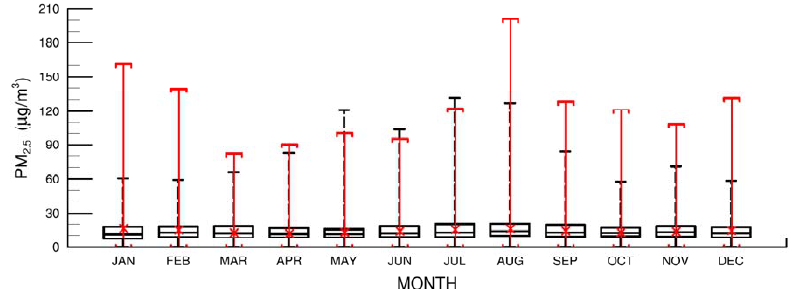
Fig. 5. Monthly statistical distributions of PM 2.5 concentrations for year 1999-2001. The black color corresponds to the 1999-2001 CMAQ simulated values, where as the red color represents the CASTNET observed values from 1998 to 2002. 10